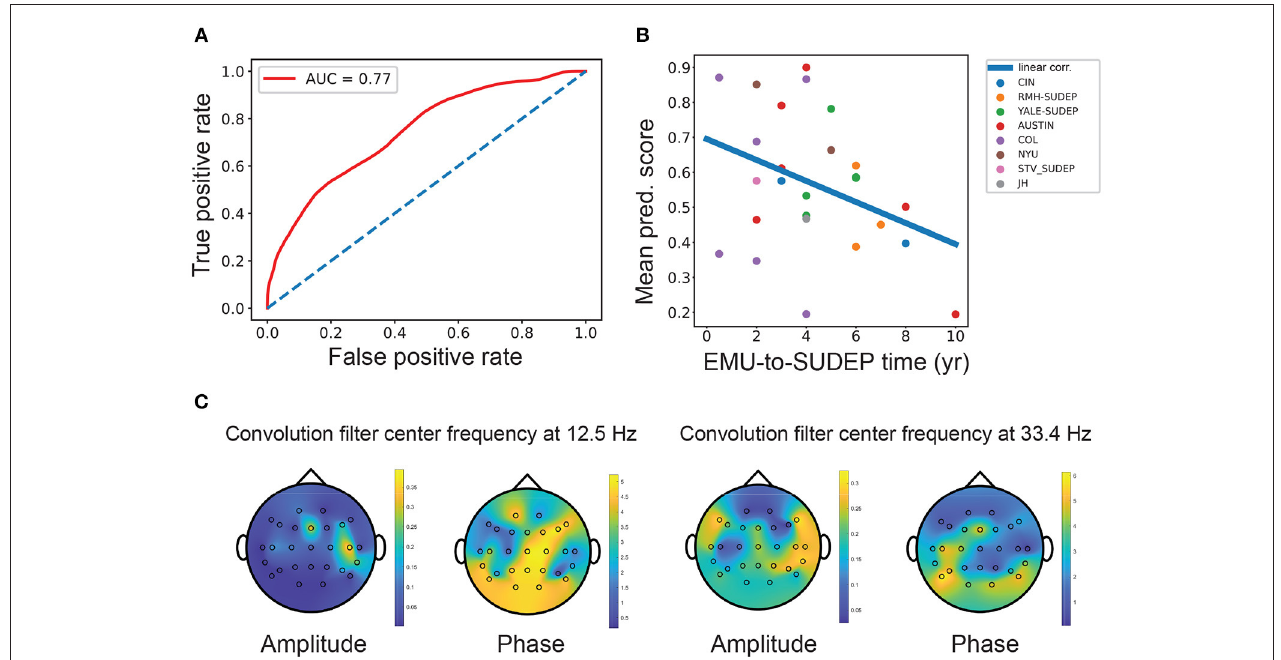
FIGURE 2 | (A) Mean receiver operating characteristic (ROC) curve [mean area under the curve (AUC) = 0.77, interquartile range (IQR): 0.73–0.80; LR classifier] obtained from SUDEP vs. non-SUDEP classification based on combined EEG and ECG features. Diagonal line shows the chance level (AUC = 0.5). (B) The mean SUDEP prediction score correlated negatively with the EMU-to-SUDEP time among the SUDEP group (Pearson’s correlation ρ = -0.38, n = 26). Color-coded points represent patients from 8 different centers. (C) Visualization and projection of two pairs of convolutional filters in the CNN onto the brain topographies of spatial patterns. The spatial patterns of “amplitude map” indicate the importance at specific channels, whereas the spatial patterns of “phase shift map” indicate the relative phase lagging.